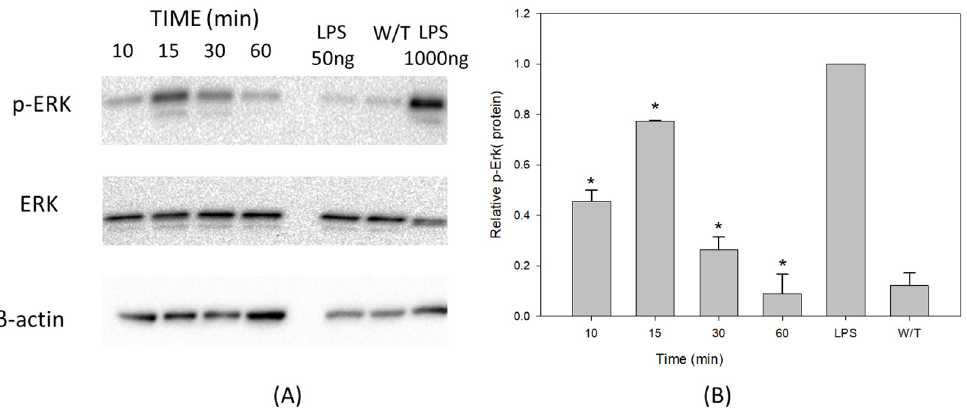
Figure 4. VCC activates the phosphorylation of ERK in THP-1. Differentiated THP-1 macrophages were treated with the VCC at 10, 15, 30 and 60 min. The positive control was LPS (1 µ g/mL). Cell lysates were analyzed by Western blot assays. ( A ) Western blot showing ERK phosphorylation under treatments with 40 pg/mL of VCC at 10, 15, 30 and 60 min. The results illustrated are a single experiment representative of three; changes in the phosphorylation of p-ERK are identified in the heading of the Western blot; below this, it is shown that the ERK content is constant in all the samples analyzed. The lower panel shows the β -actin protein at a level considered as an internal control. ( B ) Kinetics of Erk phosphorylation induced by treatments with VCC. The graphic represents results from three experiments. W/T, without treatment. Mean ± SD. * p < 0.001, significantly different from the group treated with LPS (ANOVA plus the Student–Newman–Keuls method).